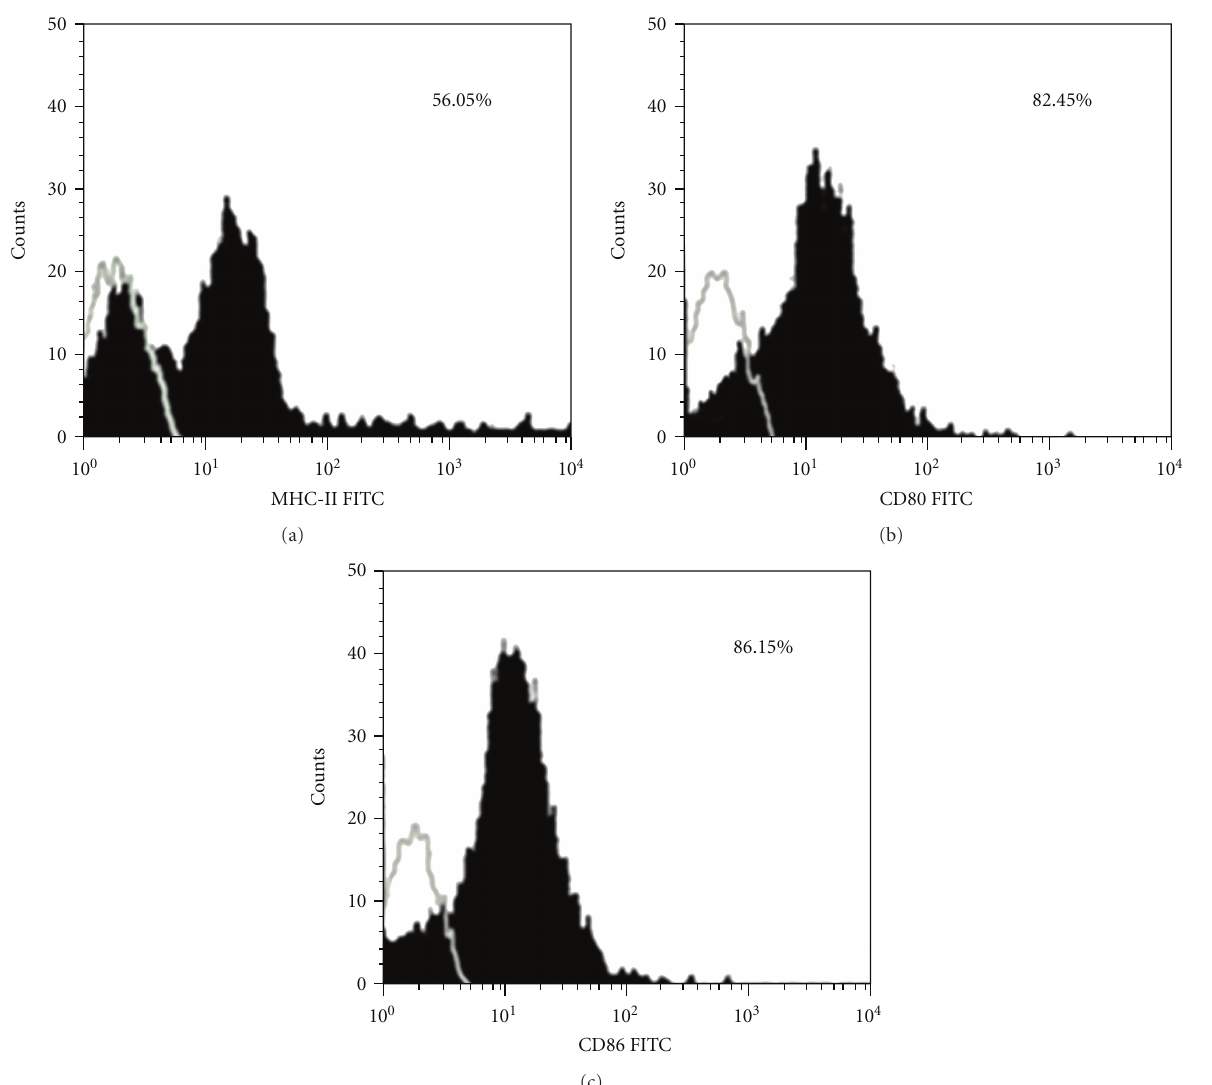
Figure 2: Expression of MHC-II (I-Ak) and B7 molecules (CD80/86) on BM-DCs. The expression of B7 or MHC-II by the indicated cell fractions is represented by filled histograms (black). The open histograms (grey) represent control staining with an isotype control antibody. Flow cytometric analysis demonstrated that over 55% of the cells express MHC-II (I-Ak) molecule (a), while 80 + % of the cells expressed B7.1 (CD80) and B7.2 (CD86) molecules (b) and (c). One representative of three independent experiments is